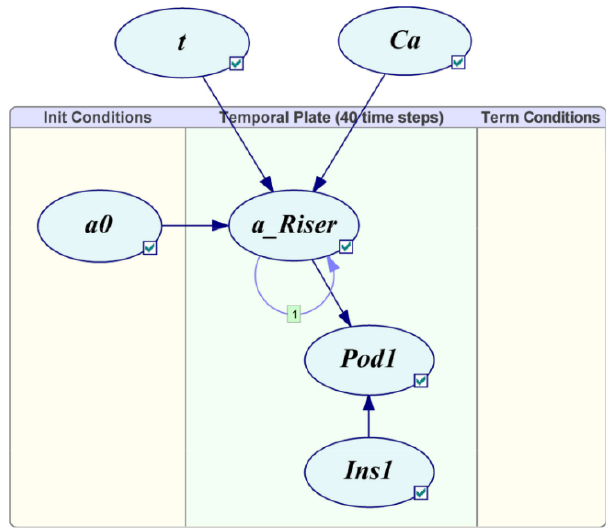
Figure 16. DBN model with inspection results.